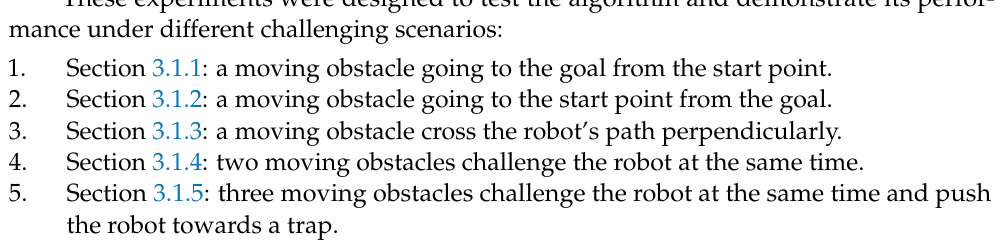
Figure 6. RGB and depth images captured from Real Sense camera. ( a ) RGB image. ( b ) Depth